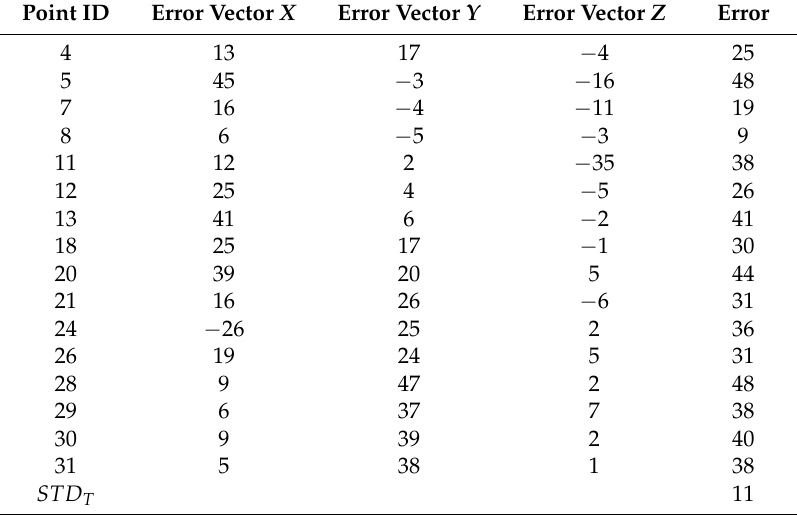
Table 4. Estimation of the standard deviation of the measurements for the targets. Distance: 3 m (unit: mm).